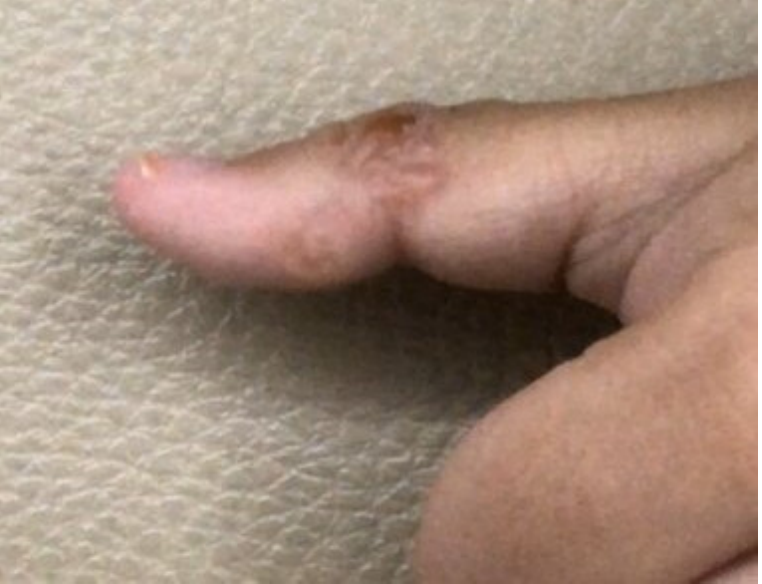
Figure 3. Hookworm-related cutaneous larva migrans on the thumb of the right hand of a young male patient showing a thread-like line of serpigenous inflammation.